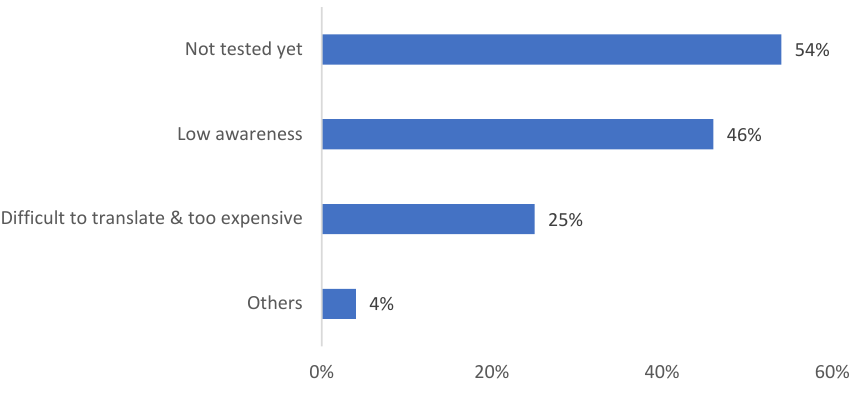
Figure 17. Student response to challenges of applying biomimicry design to the industry.